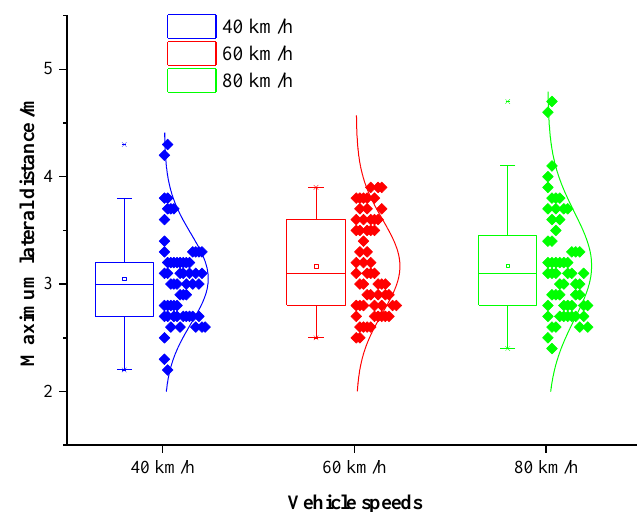
Figure 13. Box diagram of the maximum lateral distance under different speeds.